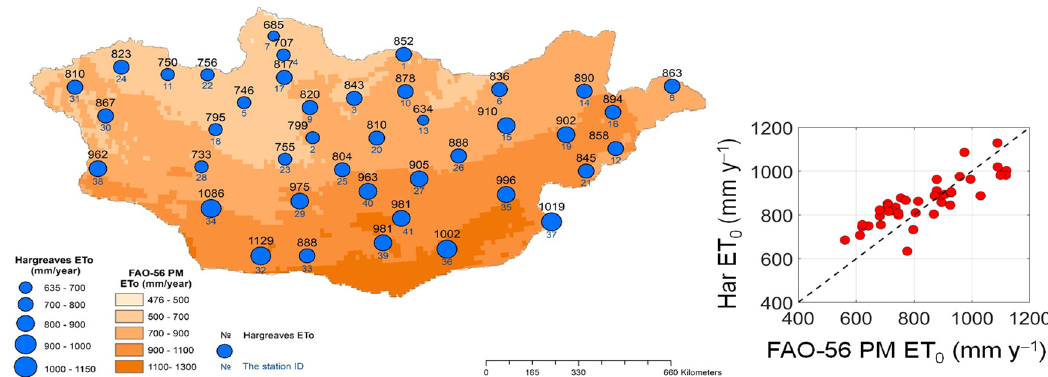
Figure 6. Map of mean annual FAO-56 PM ET 0 estimated by FAO (2009) with corresponding Har ET 0 values (blue circles). Plot on the right shows the comparison between FAO-56 PM ET 0 and Har ET 0 . Diagonal dashed line depicts the identity line (1:1 line).